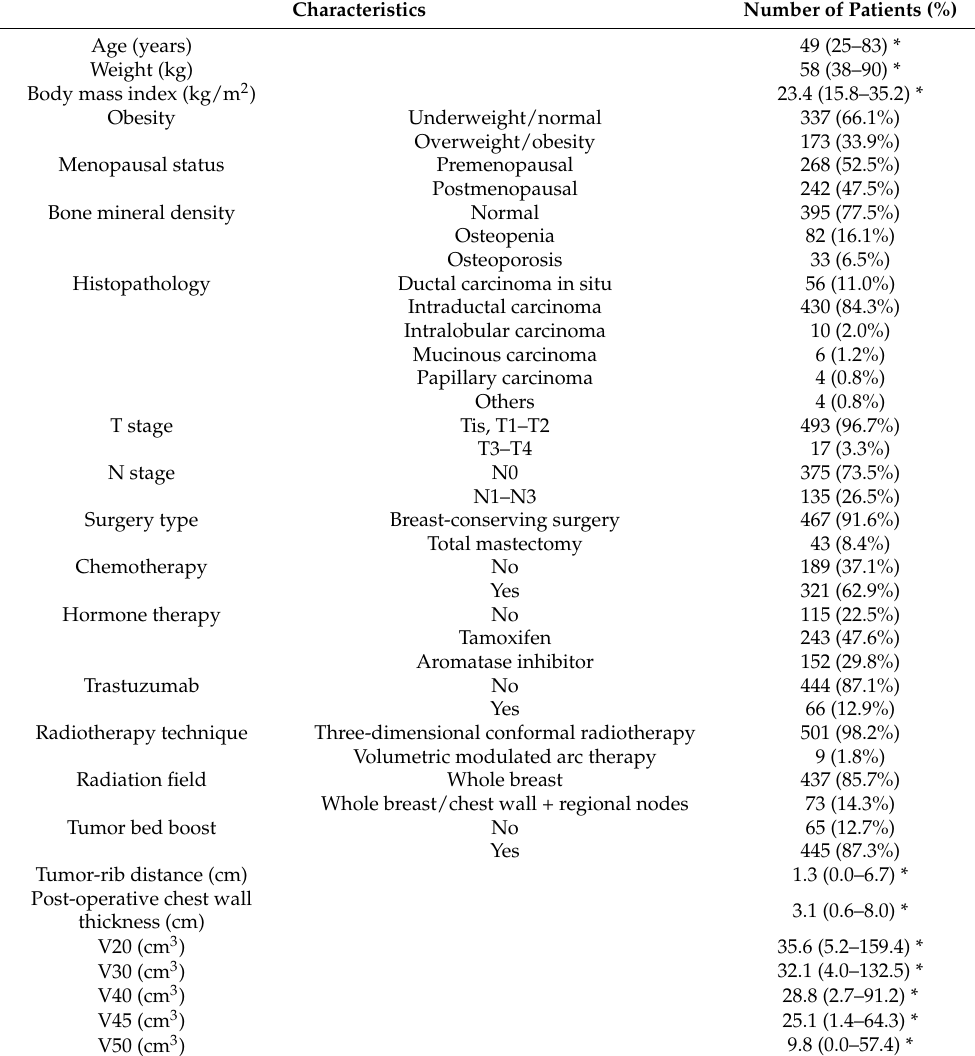
Table 1. Baseline characteristics of enrolled patients ( n =